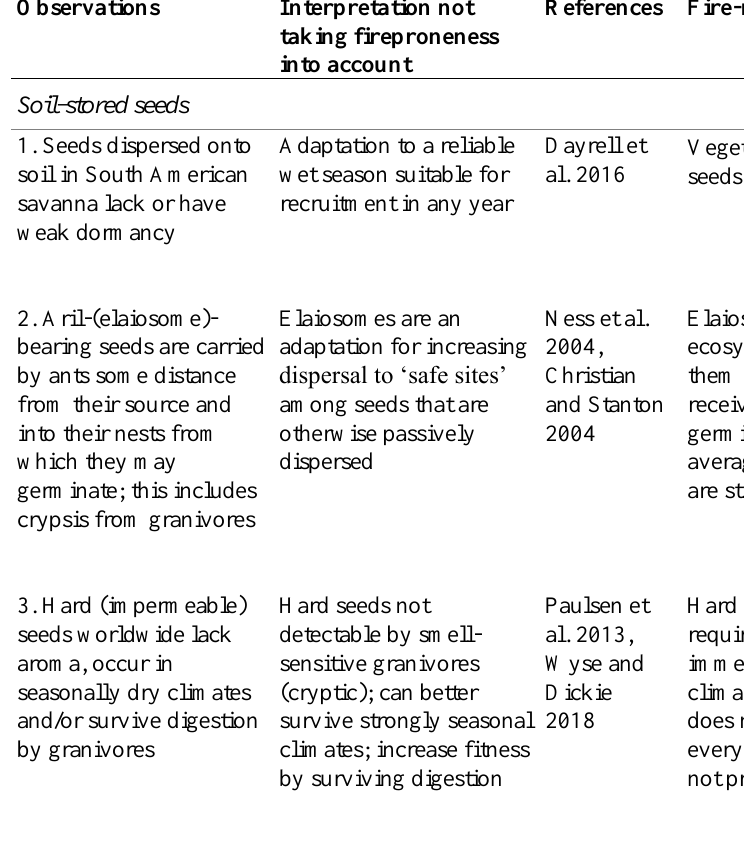
Table A2. Twenty-one (21) cases of observations on species traits and distribution interpreted in a non-fire context and additional observations and interpretations in a fire-related context that provide alternative explanations to the non-fire related observations. X, Y at the end of the the pair of numbers, X, Y, in the fire-related interpretation column refer to ranks given in Table 1 for relative importance of fire-related interpretation (X) and relative time of origin of fire-related constraint